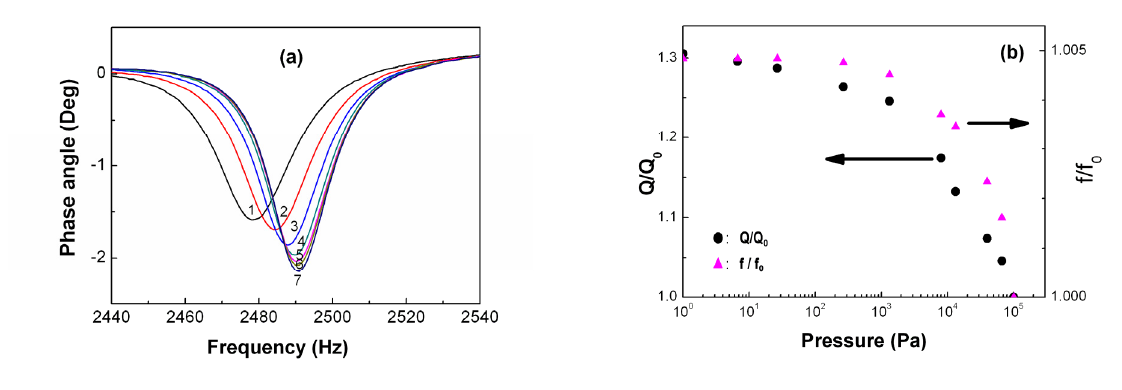
Figure 3. (a) The resonance behaviors of an MSMC in size of 3.0mm x 1.0mm x 35µm at room temperature in air at different pressures: 1). 1.0 x 10 5 Pa; 2). 8.0 x 10 4 Pa; 3). 4.0 x 10 4 Pa; 4). 1.0 x 10 3 Pa; 5). 1.0 x 10 2 Pa; 6). 1.0 x 10 1 Pa; 7). 1.0 x 10 0 Pa. ) (Solid Circle) and normalized resonant frequency (f/f ) (Solid (b) The normalized Q value (Q/Q 0 0 and f represent the Q value and resonance Triangle) as a function of air pressure. The Q 0 0 frequency of the MSMC at one atmosphere pressure.